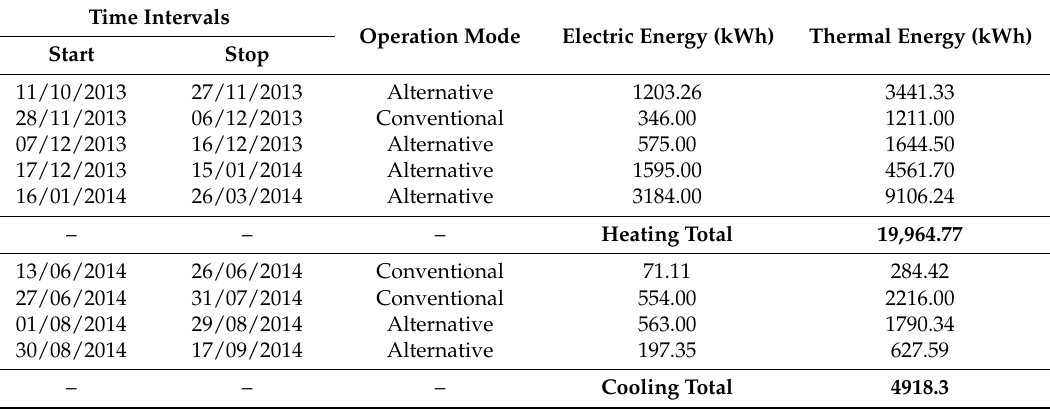
Table 2. Data from system monitoring.